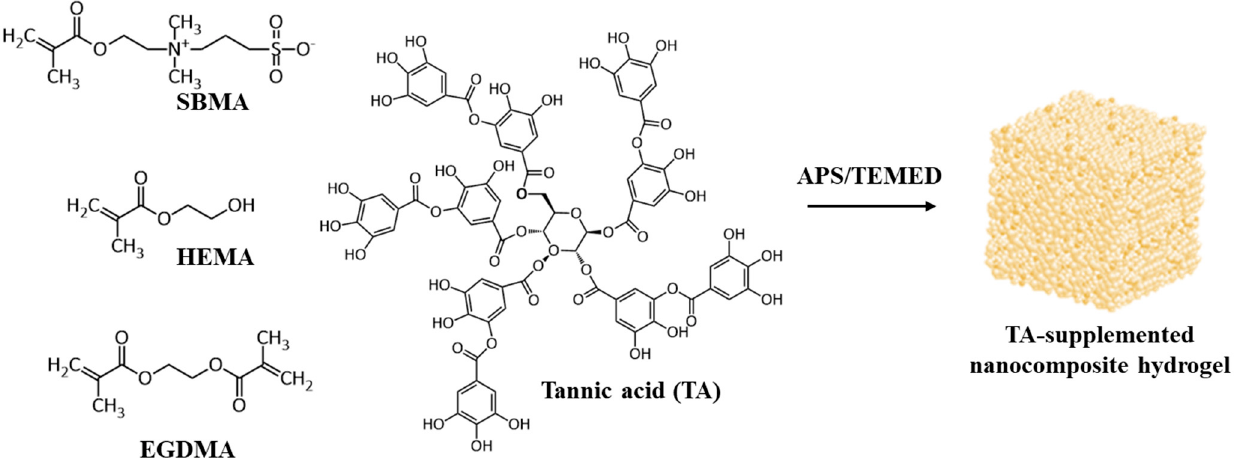
Figure 1. Schematic illustration of the formation of TA-supplemented HEMA/SBMA nanocomposite hydrogel via free radical reaction.